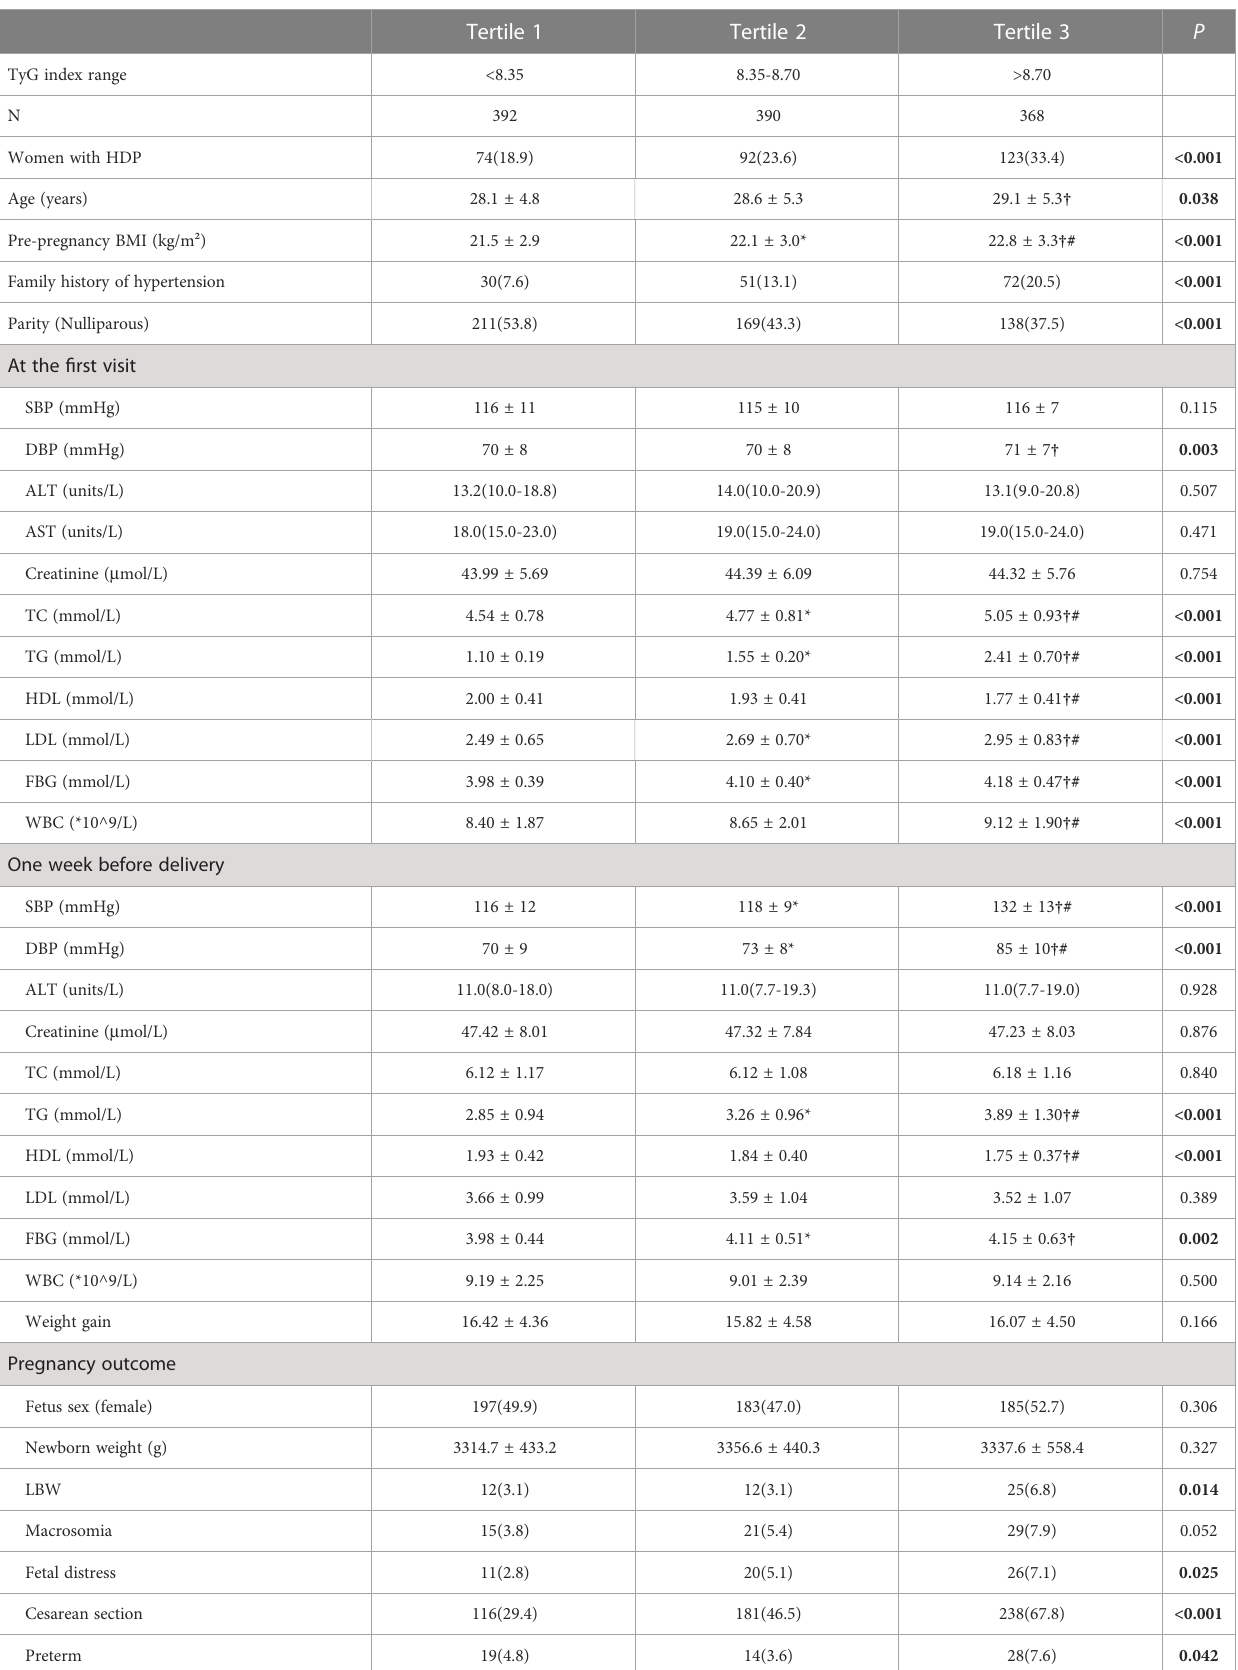
TABLE 3 Comparison of parameters during pregnancy among three groups categorized by tertiles of TyG index at the fi rst visit in the cohort